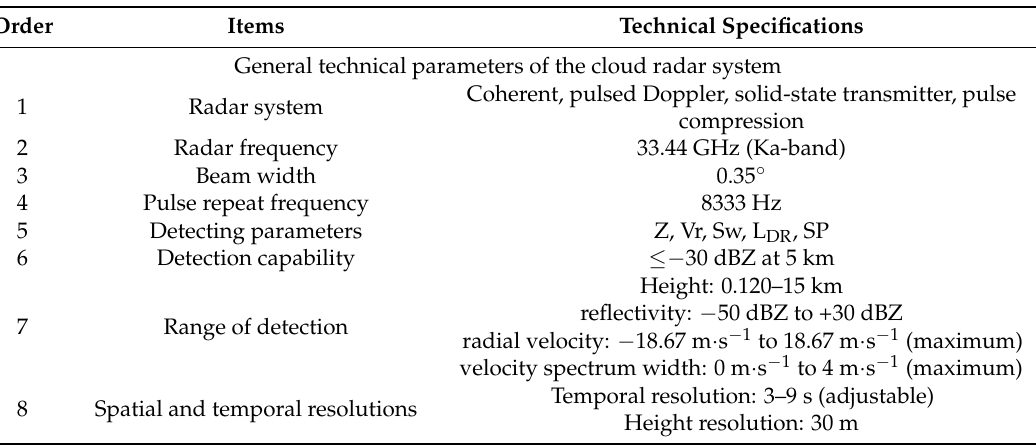
Table 1. Major technical parameters for the Ka-band solid-state transmitter cloud radar. Z—reflectivity, Vr—radial velocity; Sw—spectrum width; L DR —linear depolarization ratio; SP—Doppler spectral density.